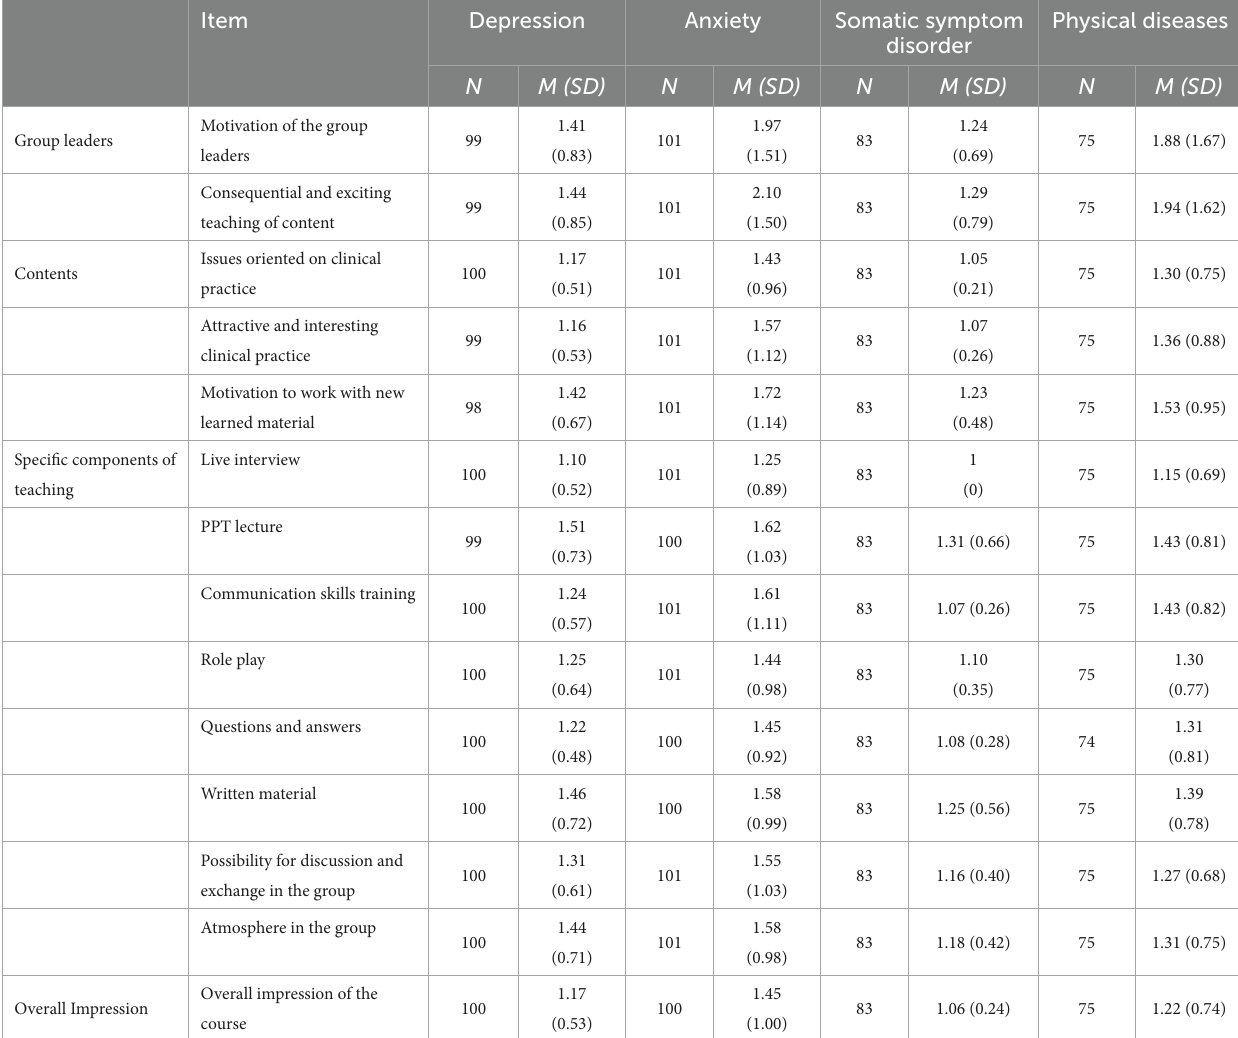
TABLE 3 Evaluation of the content, didactics and organization of the training blocks.